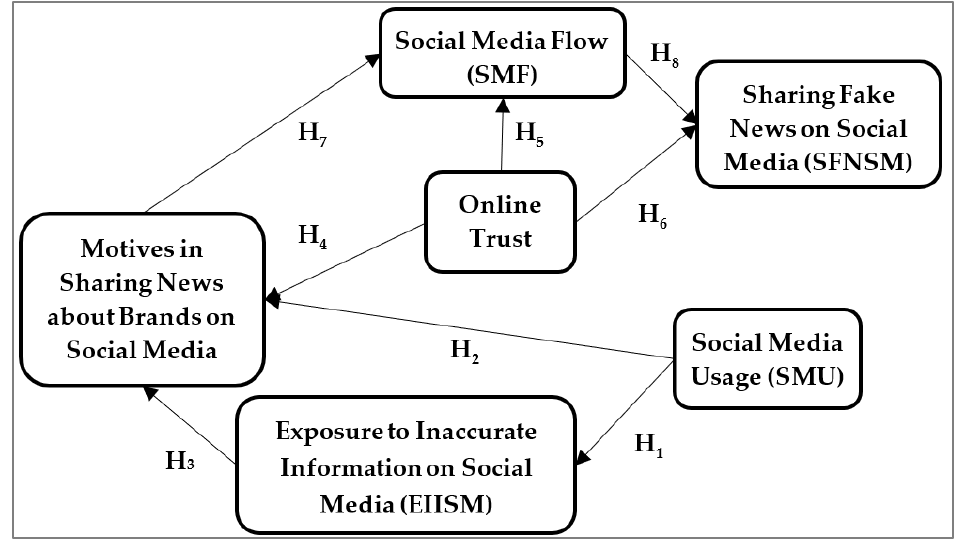
Figure 1. Theoretical model: Prerequisites of Sharing Fake News on Social Media.